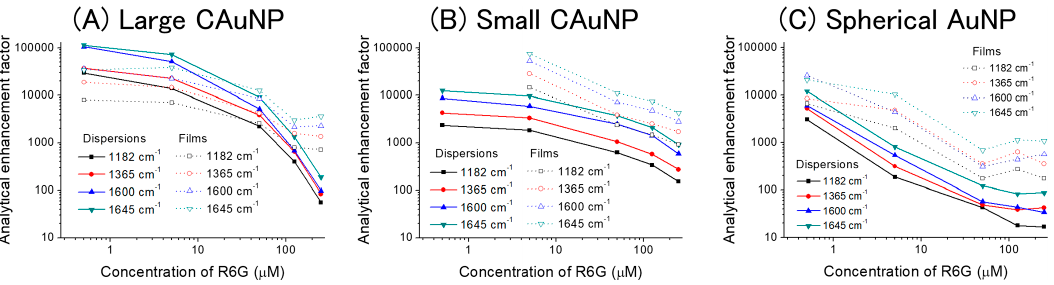
Figure 6. Analytical enhancing factors of Raman scattering of R6G at various concentrations in the dispersions and on the films of AuNPs. ( A ) large CAuNP, ( B ) small CAuNP, and ( C ) spherical AuNP. The open-marks and dotted-lines represent the films, while closed-marks and solid-lines are for the dispersions.